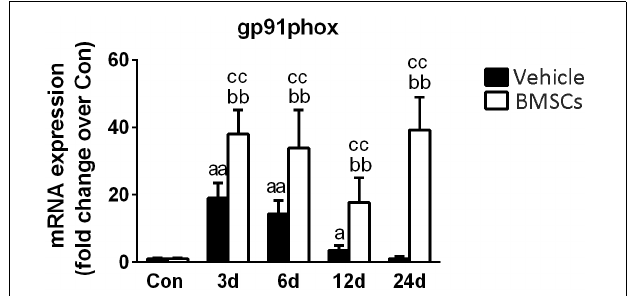
FIGURE 10 | The effects of BMSCs treatment on the expression of gp91phox. Vehicle, muscle contusion and vehicle treated group; BMSCs, muscle contusion and BMSCs treated group. Data are means ± S.D., n = 8; a Significant difference from control, P < 0.05; aa P < 0.01. b Significant difference from control, P < 0.05; bb P < 0.01. c Significant difference from the same time points of group vehicle, c P < 0.05; cc P < 0.01. BMSCs transplantation significantly enhanced the expression gp91phox in injured gastrocnemius